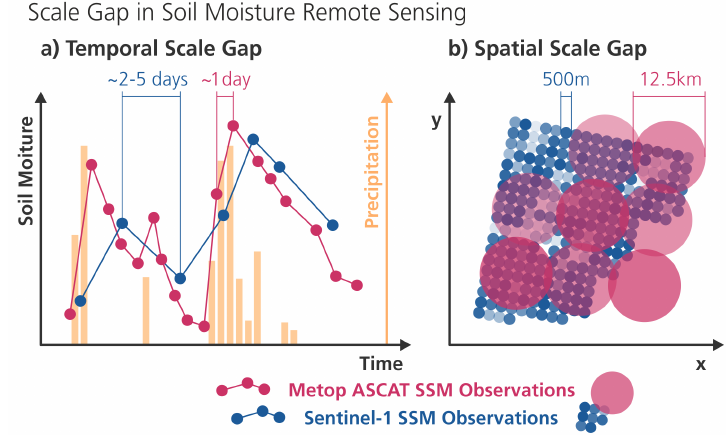
Figure 1. Schematic display of the scale gap by means of radar remote sensing for soil moisture retrieval, exemplifying that sensors with high temporal resolution have commonly low spatial resolution, and vice versa. ( a ) superior temporal resolution of scatterometer (SCAT) sensors; ( b ) superior spatial resolution of Synthetic Aperture Radar (SAR) sensors. Displayed measures (1 day vs. 2–5 days; 12.5 km vs. 500 m) relate to the input data (Metop ASCAT SSM and Sentinel-1 SSM) of the Scatterometer Synthetic Aperture Radar Soil Water Index (SCATSAR-SWI) product presented in this